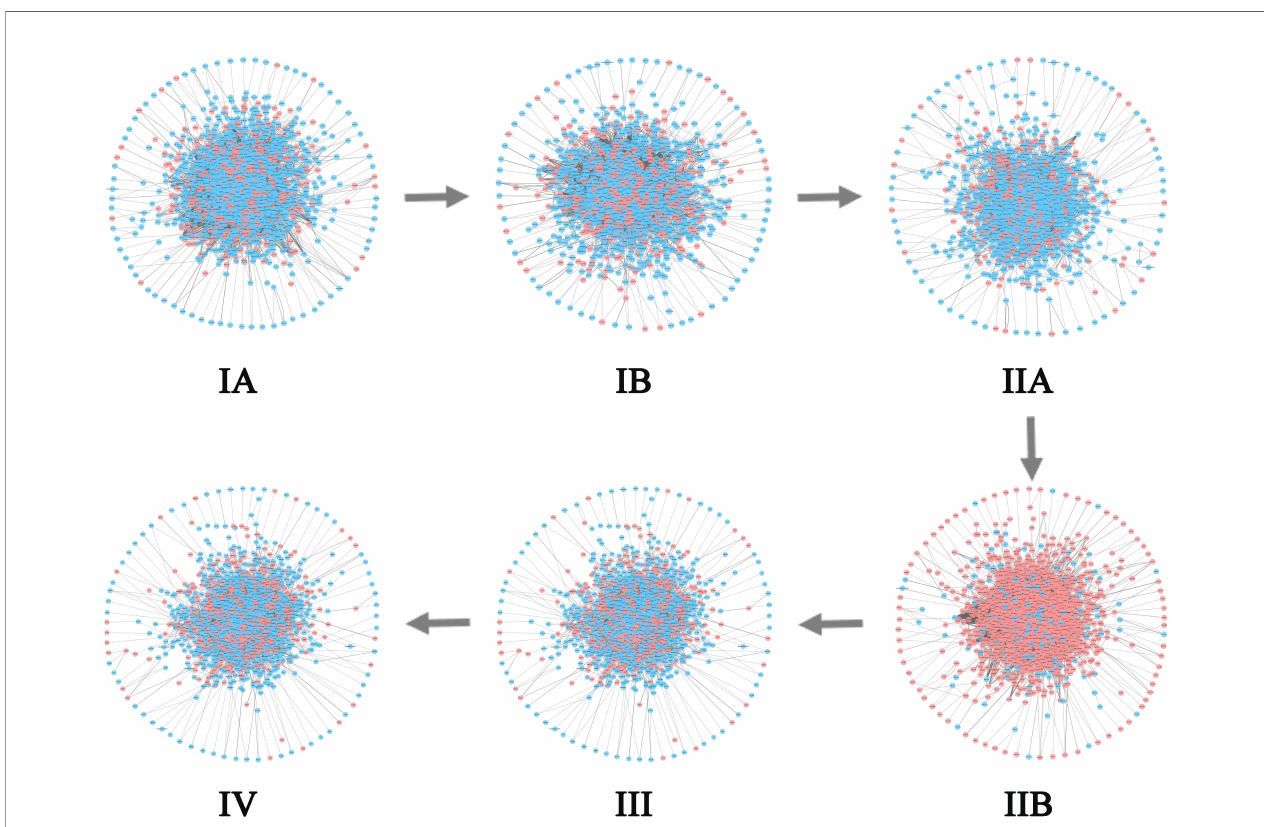
FIGURE 9 | The dynamic evolution of sJSD signal biomarkers for CESC. It can be seen that there is a signi fi cant change in the internal structure of sJSD signal biomarkers at stage